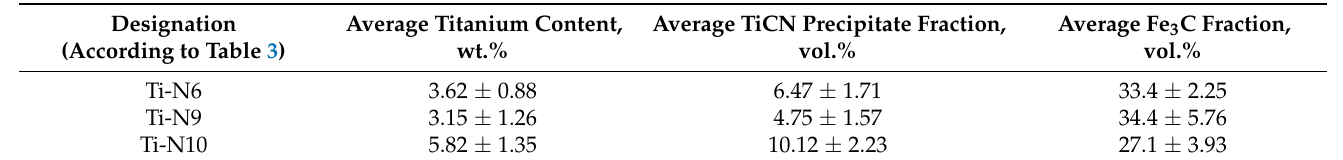
Table 5. The average titanium contents and Fe 3 C and TiCN precipitate fractions of homogeneous laser-alloyed surface layers.